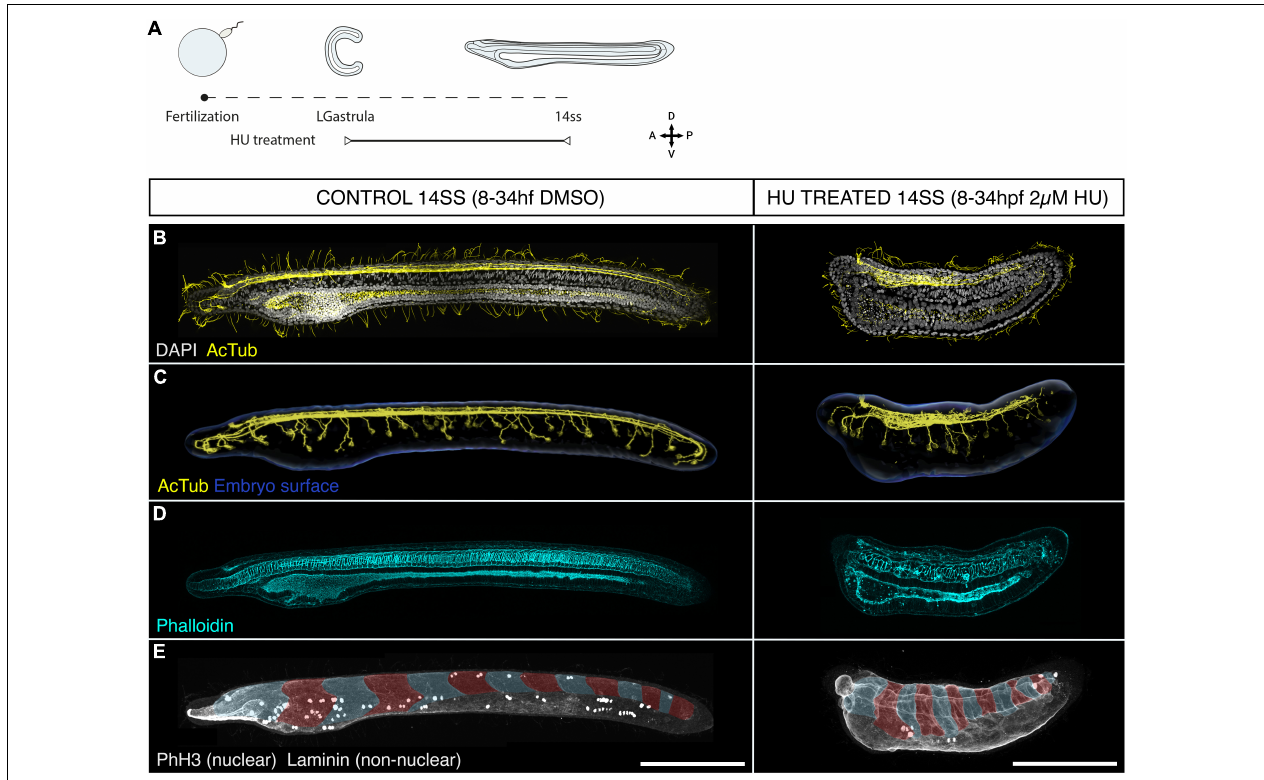
FIGURE 3 | Cell division is dispensable for body plan patterning but required for establishing a normal geometry. (A) Experimental design of hydroxyurea (HU) treatments. (B–E) Control embryos (treated with DMSO) and embryos treated with 2 µ M HU are shown side by side in lateral z-projections. (B) The general morphology of these embryos is shown through immunostaining with acetylated tubulin (cilia and axonal scaffold) and DAPI (nuclei). (C) The structure of the axonal scaffold is shown by segmentation of the acetilated tubulin channel from embryos in panel (A) . (D) Phalloidin (actin) staining in the same embryos reveals the presence of a notochord and a ventral endoderm. (E) Immunostaining with laminin and PhH3 reveals the presence of an equal number of somites in both control and treated embryos (false-colouredin blue and read overlay), and the efficacy of the treatment to arrest proliferation, which results in a significant loss of PHH3-positive nuclei in HU-treated embryos. Scale bars are 150 µ m for both control and treated embryos. HU-treated phenotype representative of n = 13 embryos